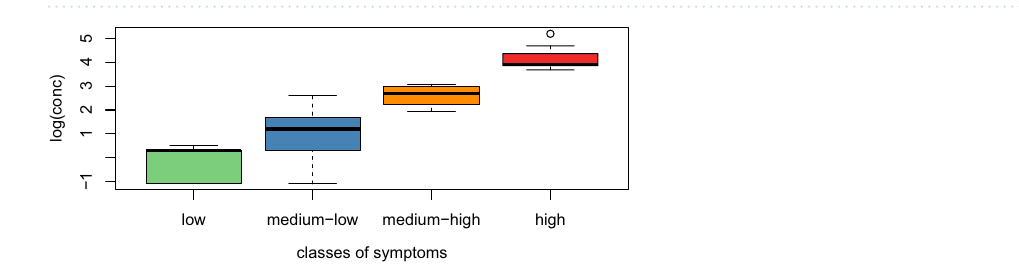
Figure 6. Boxplots of log-transformed ragweed pollen concentrations for the four classes of symptoms, namely low, medium–low, medium–high, and high. The horizontal lines in the boxplots represent the four threshold levels (L) in